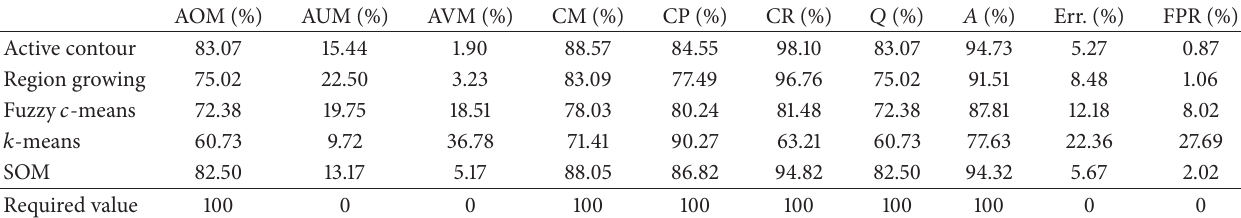
Table 2: Evaluation metrics applied in actual breast images regarding the five segmentation techniques applied in the tests. AOM (%) Active contour Region growing Fuzzy 𝑐 -means 𝑘 -means